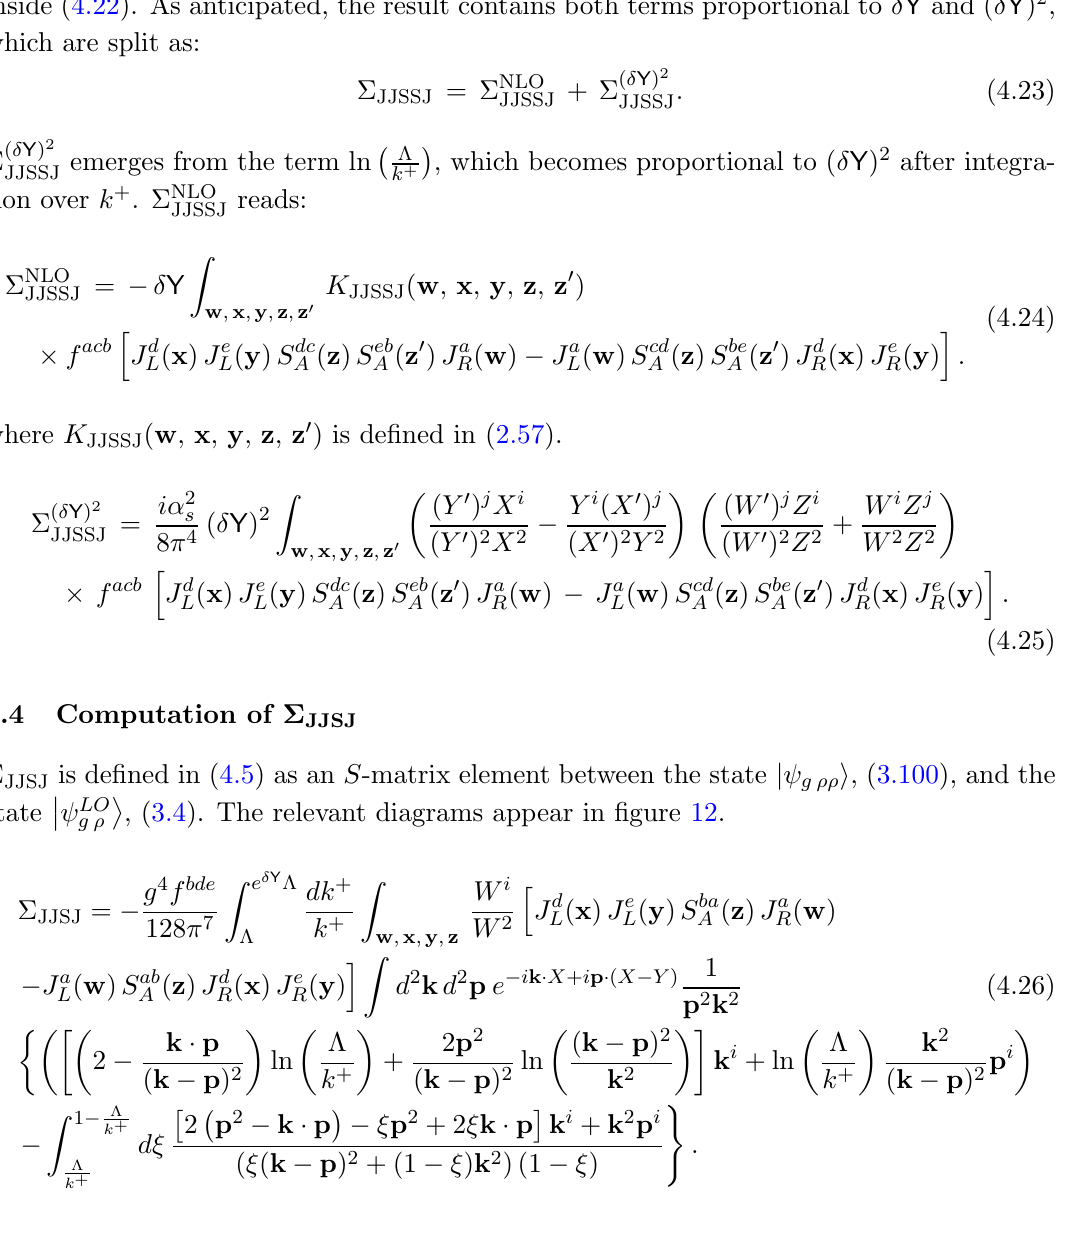
and J in (4.22) by construction do not act on S L R